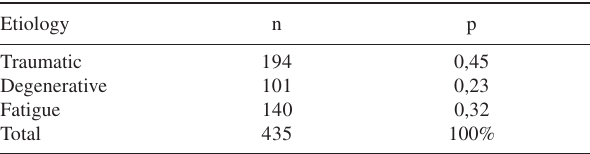
Table 2 - Diagnosis of injury according to the etiology